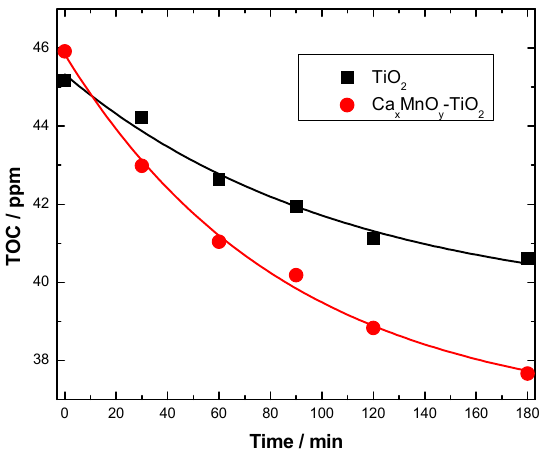
Figure 9. TOC versus time for transformation of Imazapyr under UV-Vis irradiation.